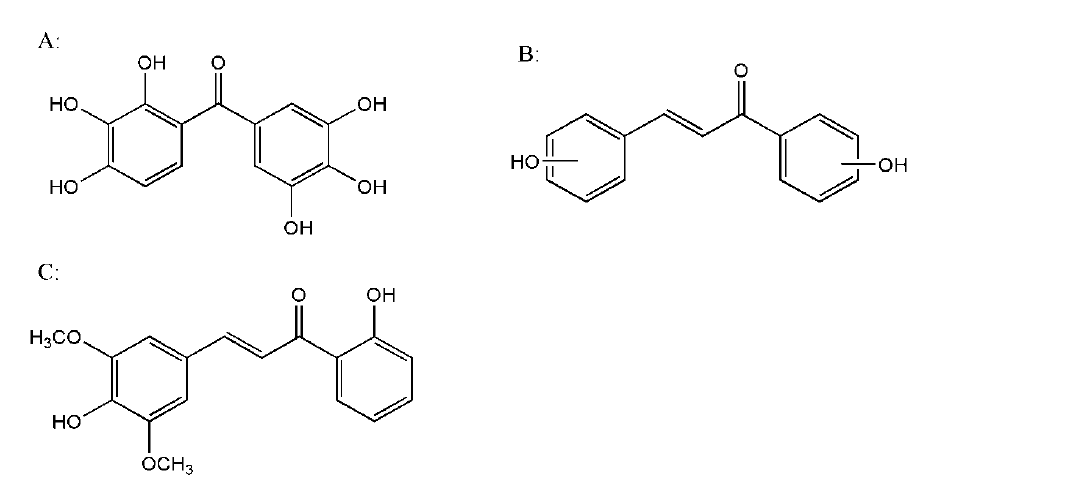
Figure 1. The structure of exifone ( A ); chalcones ( B ); C7 : the polyphenol-3,5-dimethoxy-4,2'-dihydroxychalcone ( C